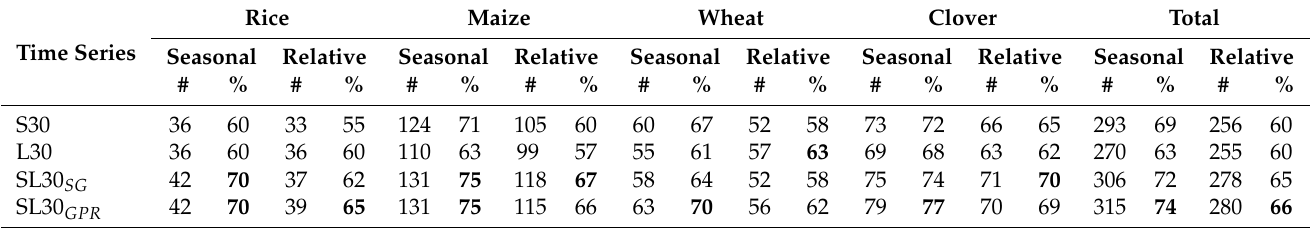
Table 4. Number (#) and accuracy detection (%) of crop seasons with respect of the number of crops planted per time series collection and crop type from 2016 to 2019 over all available parcels. The highest accuracy (%) per crop type and method columns is bolded.